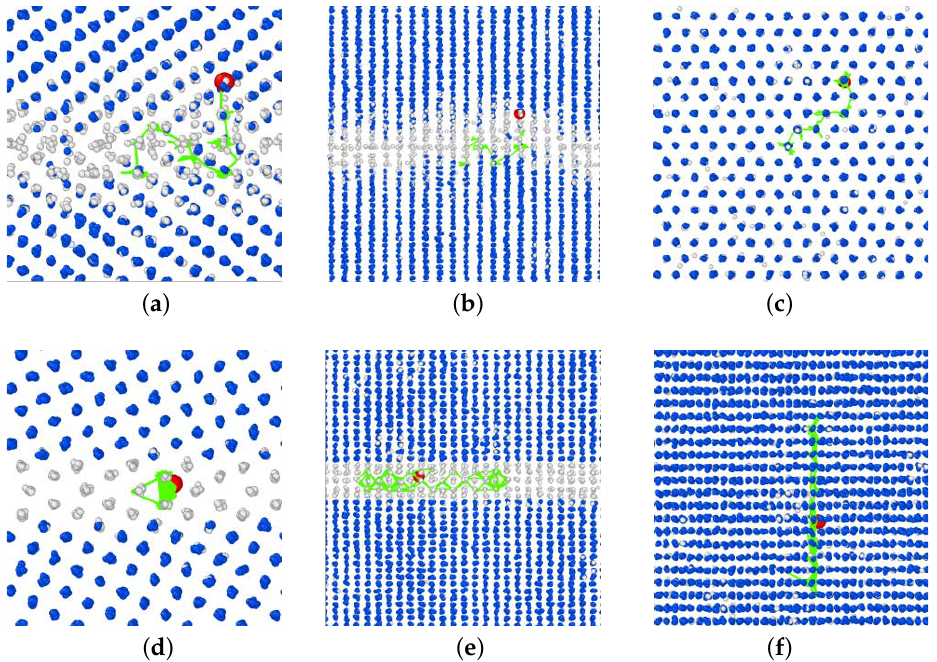
Figure 6. Trajectory of P atom ( a – c ) for the case of a P atom put at Site 0 in Σ 3 GB (Figure 5a) and ( d – f ) for the case of a vacancy put at the nearest neighbor site of the P atom at Site 2 in Σ 5 GB (Figure 5f): The case of 800 K is shown for both GBs. The left graphs ( a , d ) show the front view that is the x-y plane, the centers ( b , e ) are the side view that is the y-z plane, and the right is the top view that is x-z plane. The large red particle is the P atom at the last step. The color of Fe atoms is the same meaning as Figure 1. The green line shows the trajectory of the P